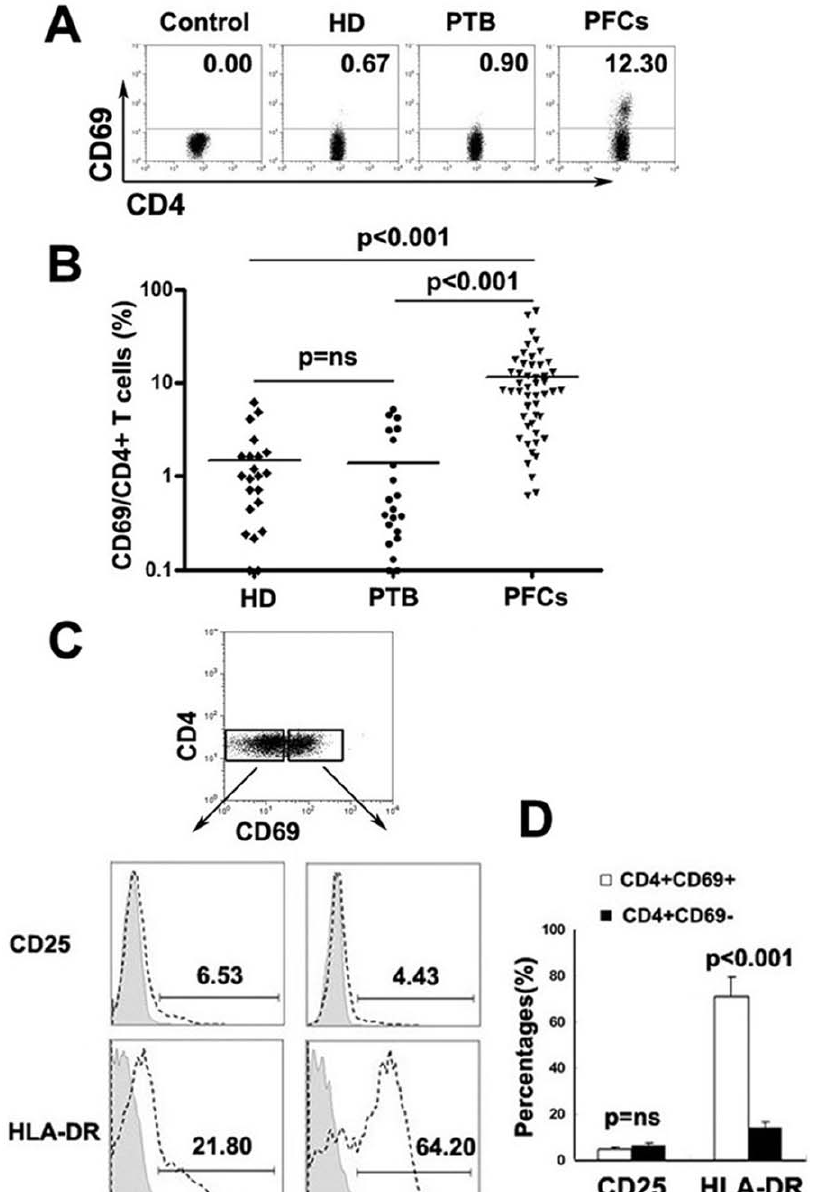
Figure 1. Significantly higher expression of CD69 on CD4 + T cells in PFCs from patients with TBP without any stimulation. (A) Representative expression of CD69 on CD4 + T cells was determined by FACS in PBMCs from healthy donors (HD), patients with pulmonary tuberculosis (PTB) and pleural fluid cells from patients with TBP (PFCs). (B) Summary data of CD69 expression on HD (n=22), PTB (n=21) and PFCs (n=50). Each symbol represents a value from a single donor. Horizontal lines denote mean expression. (C) Expression of CD25 and HLA-DR on CD4 + CD69 + and CD4 + CD69 2 T cells. The expression of each marker within the CD4 + CD69 + and CD4 + CD69 2 T cell subsets is shown by the dotted line. (D) Average value of CD25 and HLA-DR expression on CD4 + CD69 + and CD4 + CD69 2 T cells from six independent experiments is demonstrated. ns,